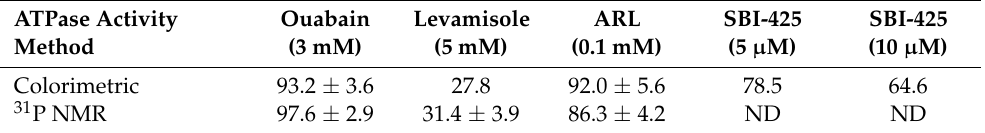
Table 1. Comparison of ATP hydrolysis activity determined by colorimetric and 31 P NMR method. The activities were determined in % considering 100% activity in the absence of inhibitor under optimal conditions for the determination of NKA activity, as described in materials and Methods. Ouabain (NKA specific inhibitor); Levamisole and SBI-425 (TNAP inhibitors); ARL-67156 (CD39 specific inhibitor). ATPase activity was colorimetrically determined discontinuously, at 37 ◦ C and 31 P NMR activity was determined by measuring inorganic phosphate released, in 50.0 mM HEPES reaction medium, at 25 ◦ C using medium with pH 7.5, containing 3.0 mM ATP, 10.0 mM KCl, 5.0 mM